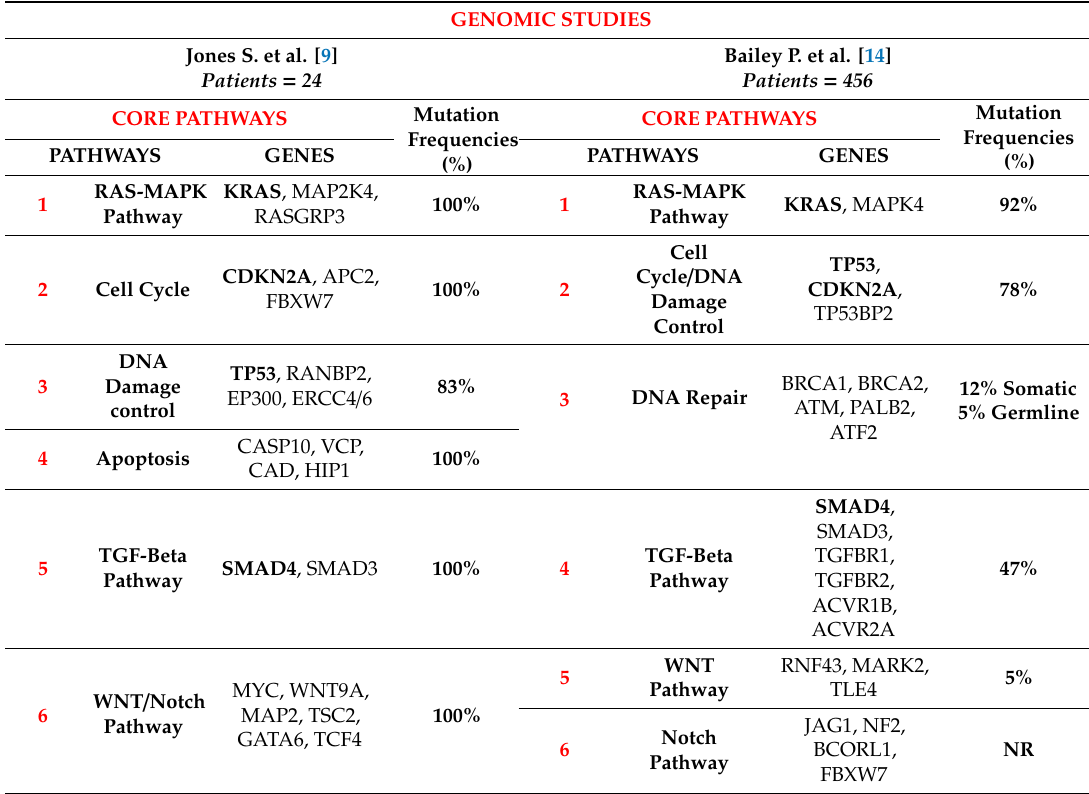
Table 1. Comparison between the core pathways identified in pancreatic ductal adenocarcinoma (PDAC) by Jones et al. [9] and Bailey et al. [14] with related frequencies of